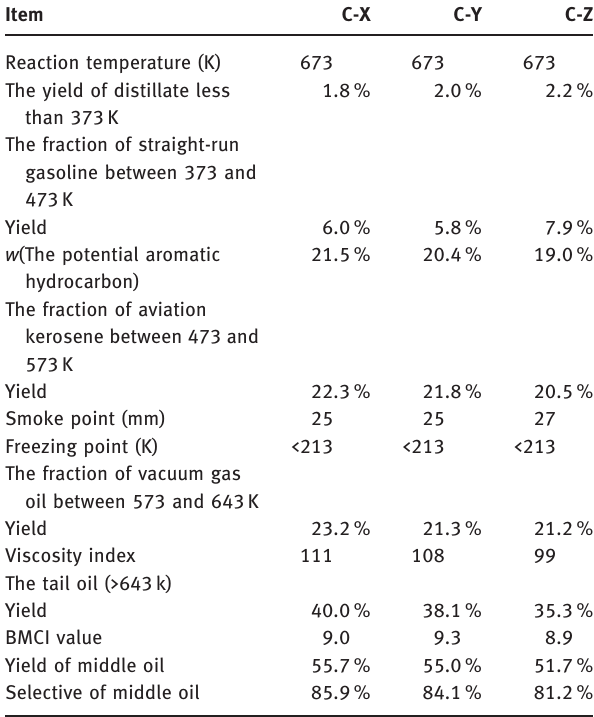
Table 4: The evaluation results of catalyst with homemade on the hydrocracking device(conditions: reaction temperature, yield, smoke point, freezing point, viscosity index, BMCI value, yield of middle oil, and selective of middle oil of C-X, C-Y, and